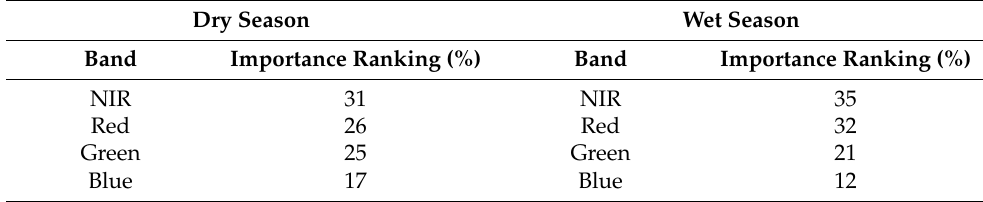
Figure 4. Differences of gullies and other land cover types’ reflectance by bands and seasons (G: gully; F: forest; Bu: built-up; BS: bare soil; MBS: mixed bare soil; V: vegetation; A: agriculture; mean ± 95% confidence intervals; the difference was not significant if confidence range intersects the dashed line). Table 2. PlanetScope bands ranking in discriminating gullies against the surrounding land